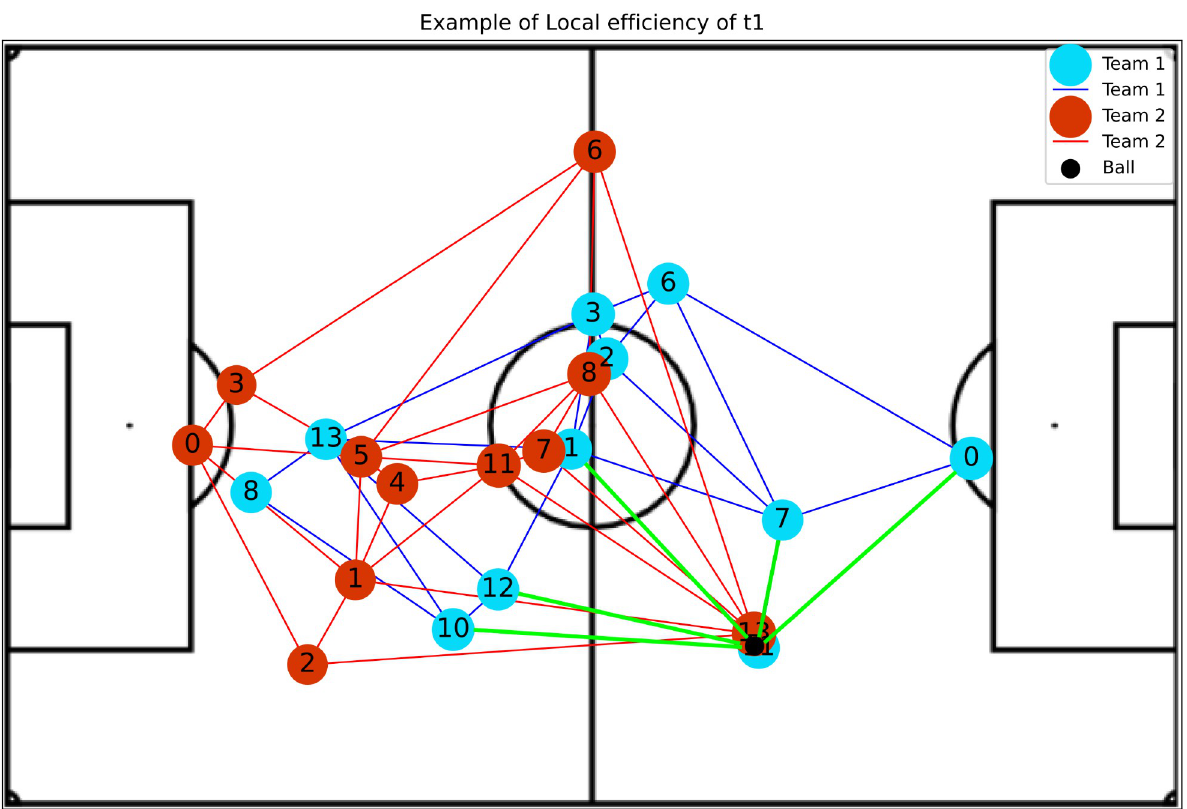
Fig 5. The image shows a situation with high local efficiency of player 11 at the moment that he received the ball, having five options to make the pass (green edges). This situation demonstrates that if he was undermarked (unable to receive the ball) this play would not be